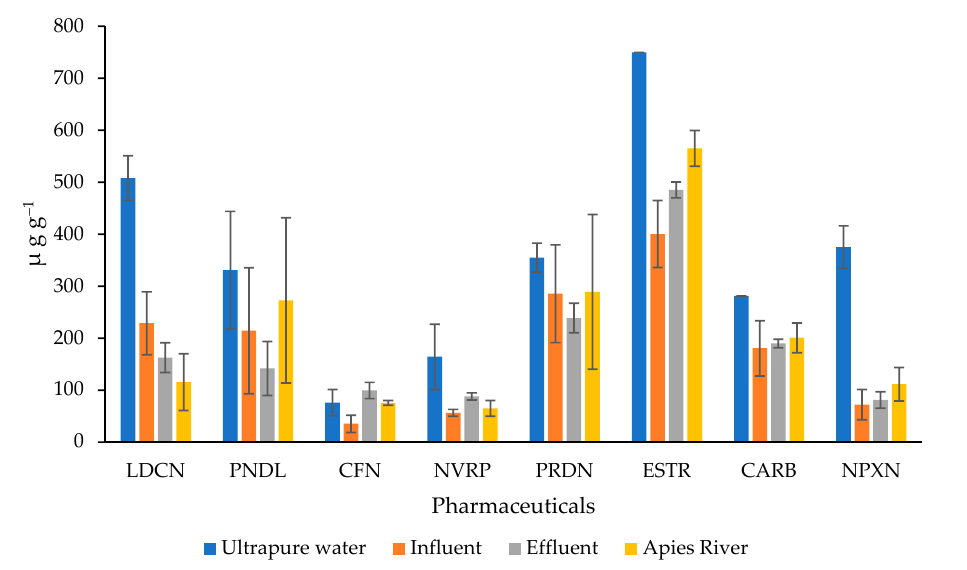
Figure 7. Adsorption of selected pharmaceuticals in environmental water. Table 5. Removal efficiencies or adsorption capacities of selected pharmaceuticals with various adsorbents − 1